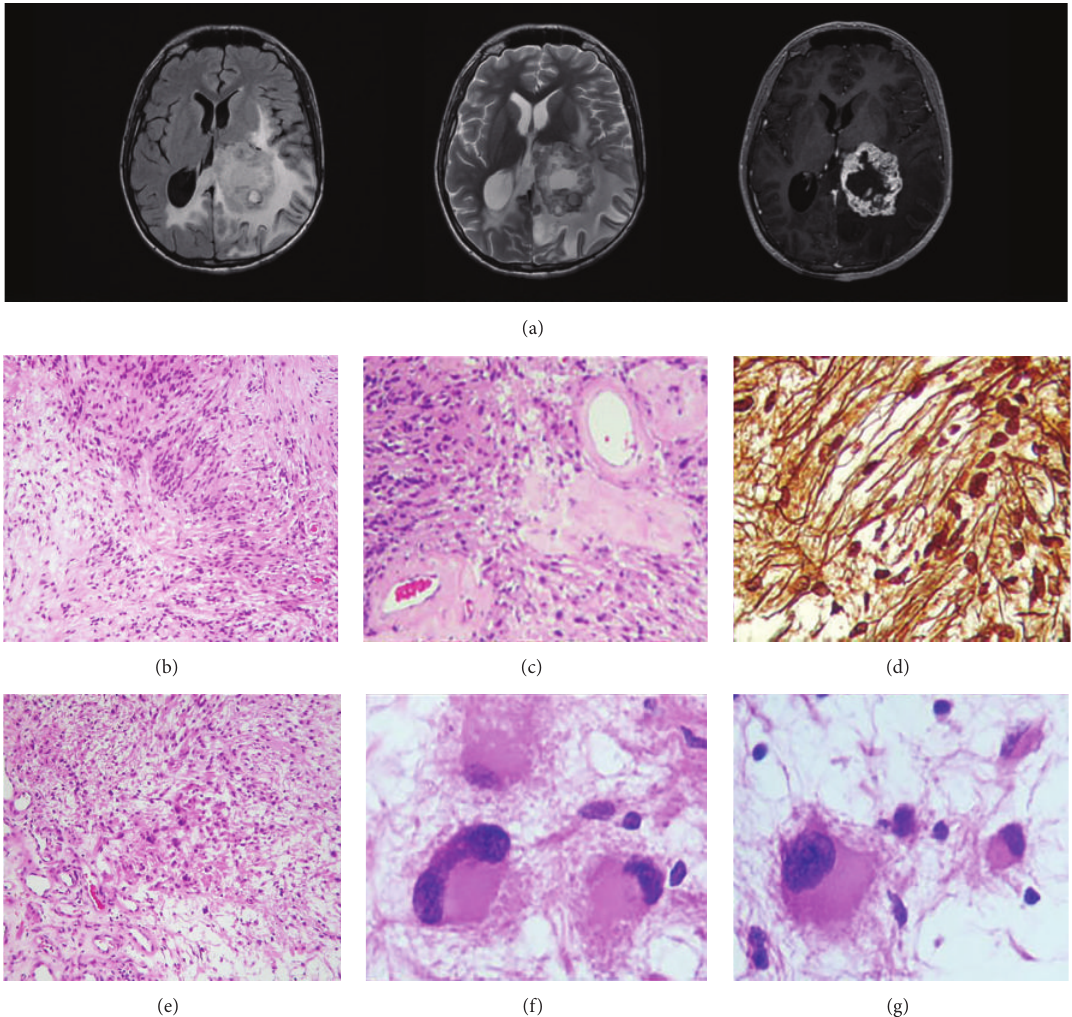
Figure 1: Magnetic resonance imaging scans/histopathological findings. (a) Postcontrast T 1 ( right ) and T 2 weighted ( center ) sequences demonstrate a cystic, avidly enhancing mass, while the fluid-attenuated inversion recovery (FLAIR) sequence ( left ) shows enlargement of the cornu occipitale sinister with surrounding white matter oedema, consistent with ventricular entrapment; this might as well explain the blurred vision due to affection of the geniculocalcarine tract. (b) Transition zone, in a spindle cell neoplastic population, from an Antony A pattern ( left ) to an Antony B area ( right ). H&E. (c) High magnification photomicrograph showing intratumoural hyalinised vessels. H&E. (d) Reticular fibers stain. A pericellular reticulin frame, trademark of neurilemmal phenotype, is noticeable. (e) Antony B field with a small population of neoplastic, plump, gemistocyte-like cells. H&E. ((f), (g)) High magnification photomicrographs of the cells shown in (e): voluminous cells with eccentric nuclei and senescent atypia are